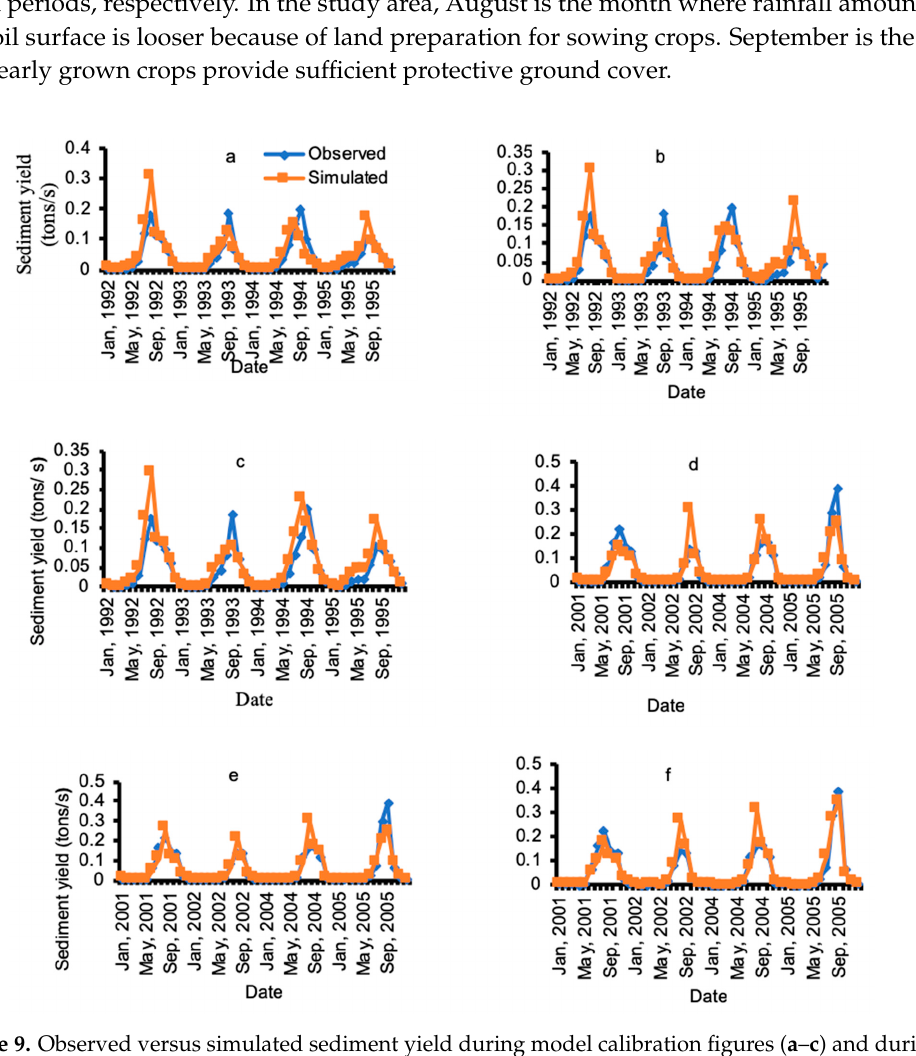
Figure 9. Observed versus simulated sediment yield during model calibration figures ( a – c ) and during model validation figures ( d – f ) under 1986, 2001 and 2015 LULC,